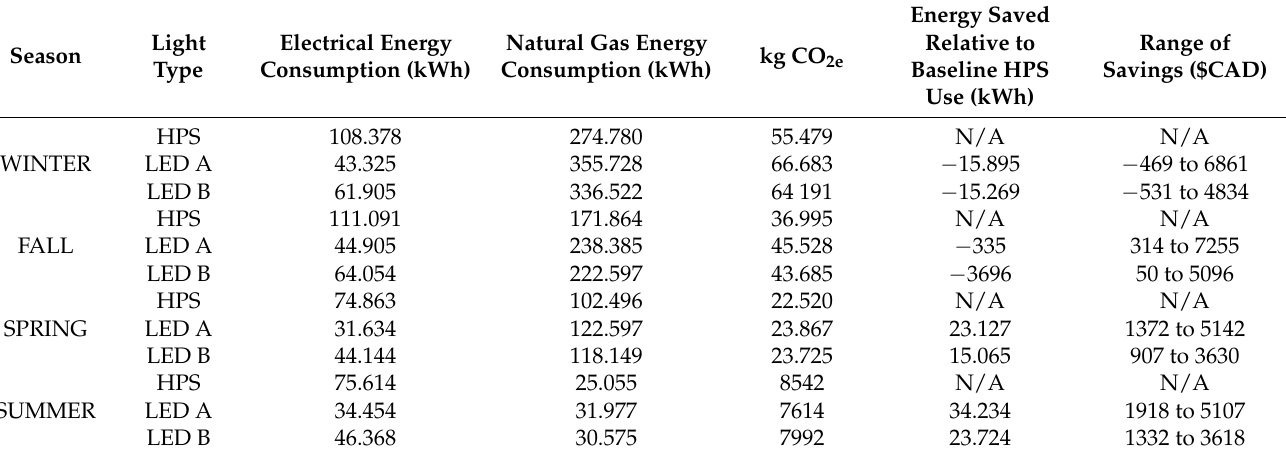
Table 13. Summary of lighting simulation